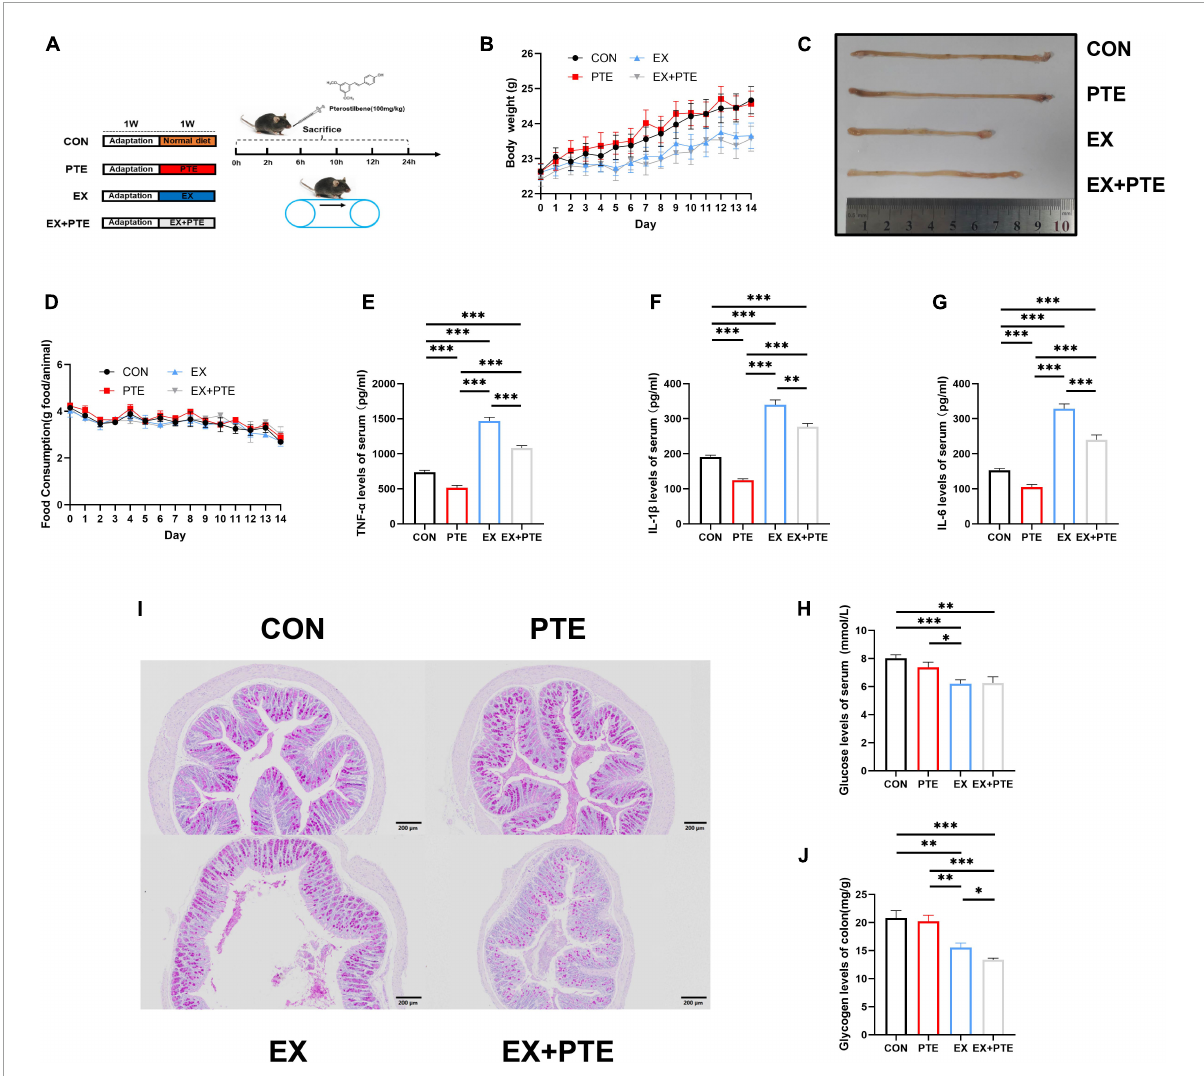
FIGURE1 Exercise-induced intestinal barrier disruption and inflammation in C57BL/6 mice. (A) Part1: mice gavaged with pterostilbene (100 mg/kg/day) and sacrificed at 0, 2, 6, 10, 12, 24 h ( n = 4); Part 2: mice treatment with pterostilbene (100 mg/kg/day) or exhaustive exercise for 7 days. (B) Body weight was measured one time a day ( F = 1.384, p = 0.261). (C) Representative photographs of colons from CON, PTE, EX, and EX + PTE. (D) Food intake was measured one time a day ( F = 0.612, p = 0.626). (E) TNF- α (PTE: F = 63.793, p < 0.001; EX: F = 287.397, p < 0.001; interaction: F = 4.354, p < 0.05), (F) IL-1 β ( χ 2 = 28.102, p < 0.001), (G) IL-6 (PTE: F = 40.789, p < 0.001; EX: F = 209.477, p < 0.001; interaction: F = 3.625, p < 0.05), and (H) glucose were measured by ELISA kits immediately (PTE: F = 0.774, p = 0.384; EX: F = 18.084, p <